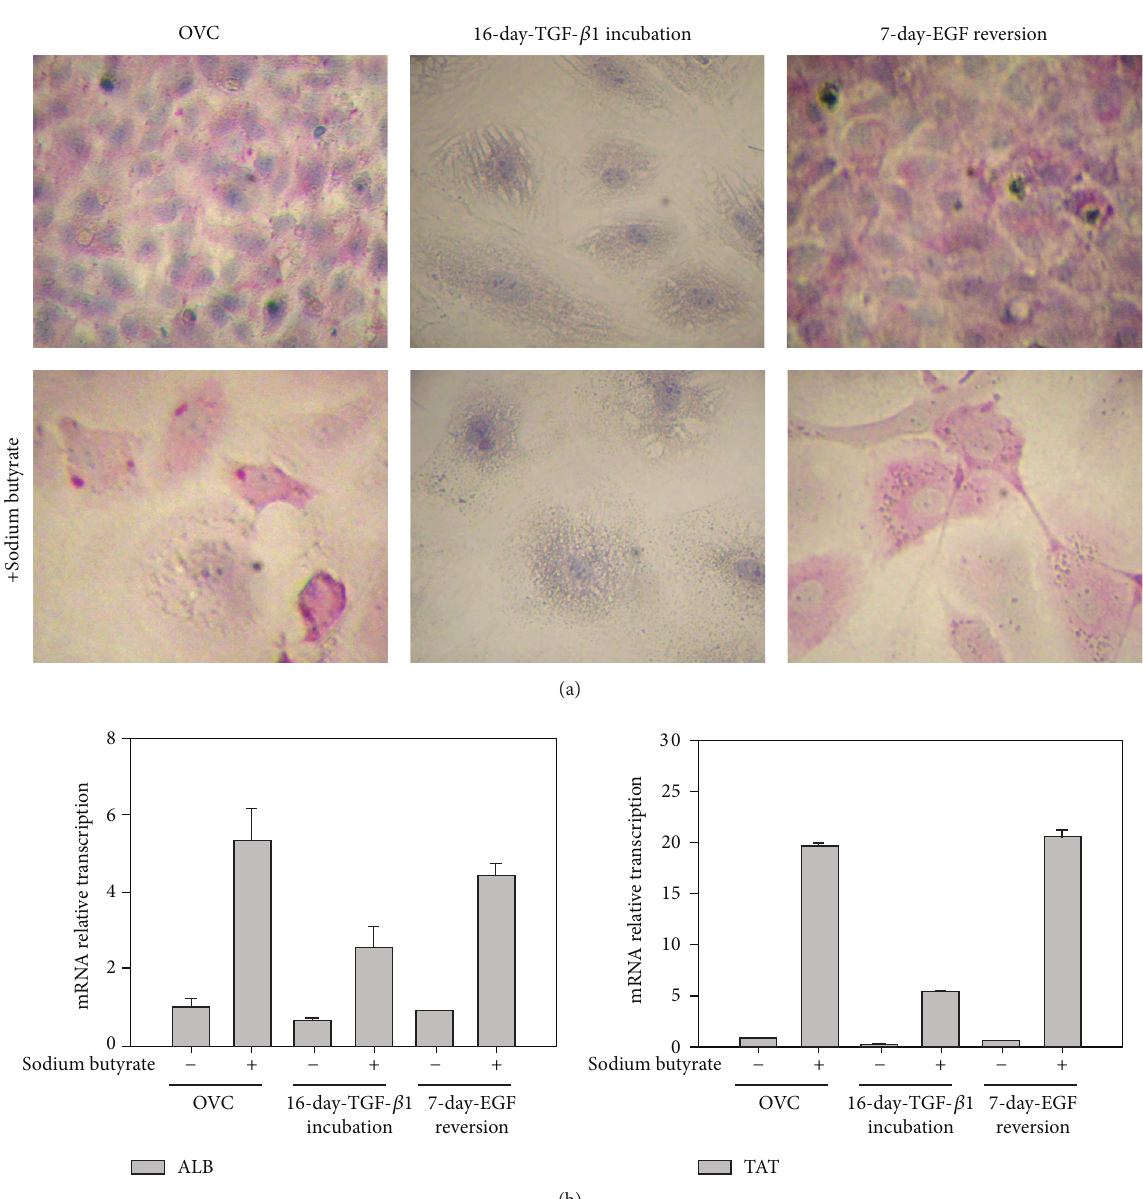
Figure 4: EGF retained thedifferentiation potential that was impaired by TGF- 𝛽 1in hepatic oval cells. (a)Hepatocyte differentiation, detected by PAS staining, could be induced by sodium butyrate in control oval cells and cells allowed to 7-day EGF recover from TGF- 𝛽 1 exposure whereas hepatocyte differentiation could not be seen in cells after 16-day TGF- 𝛽 1 incubation. (b) Sodium butyrate increased more ALB and TAT transcription in control oval cells and EGF-reversion cells than in 16-day TGF- 𝛽 1 treated